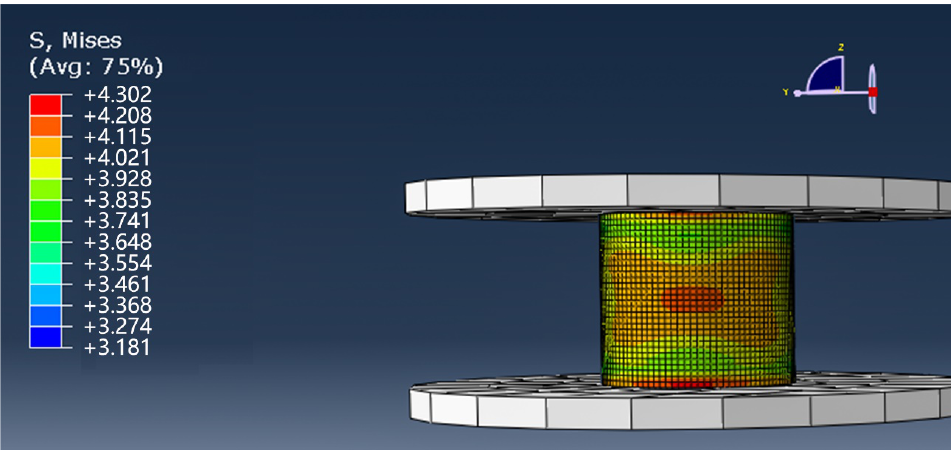
Figure 10. The compression simulation of the 3D tubular woven composites at 0.01 s.